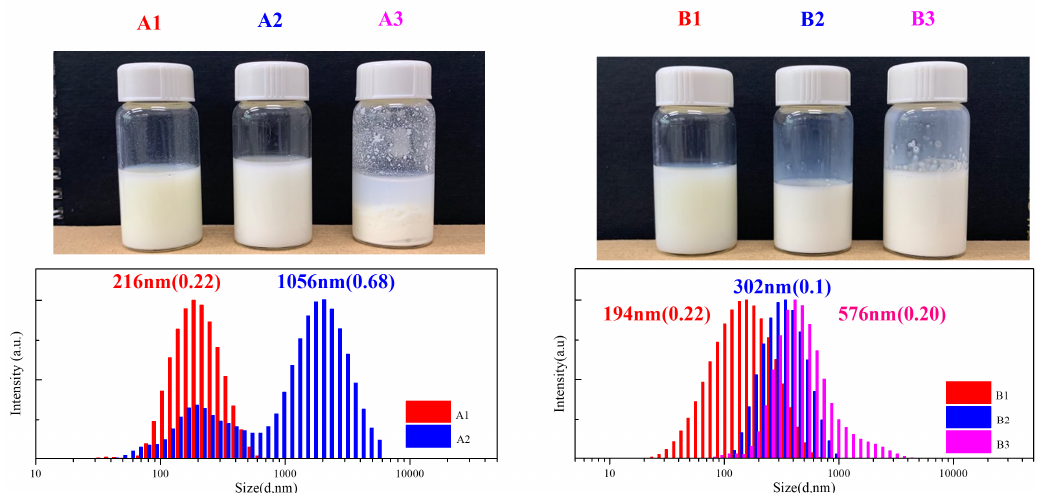
Polymers 2020 , 12 , x FOR PEER REVIEW Figure 8. Emulsion polymerization and DLS measurements of PEG-b-PDVBP. Figure 8. Emulsion polymerization and DLS measurements of PEG-b-PDVBP.